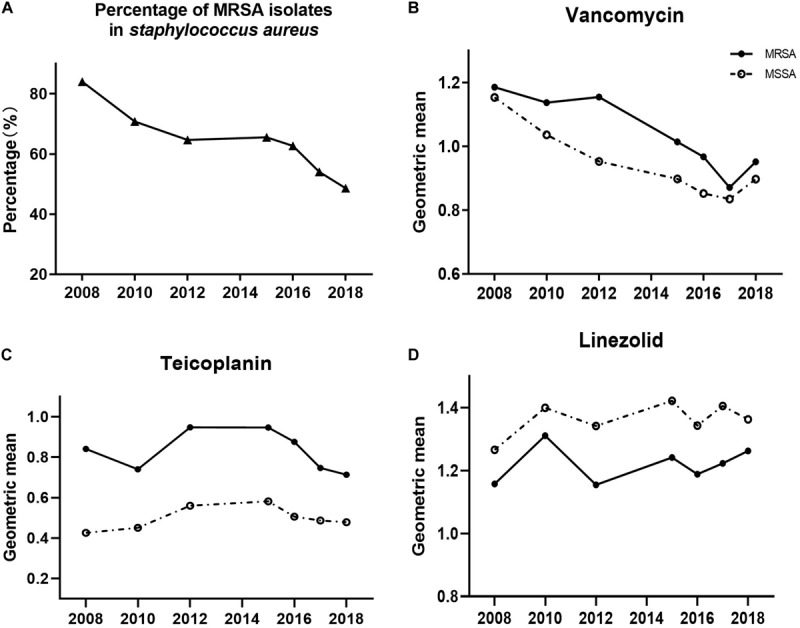
Shifts of MRSA proportion (A), and MICs of (B) vancomycin, (C) teicoplanin, and (D) linezolid in MRSA (solid circles) or MSSA (open circles), 2008–2018.